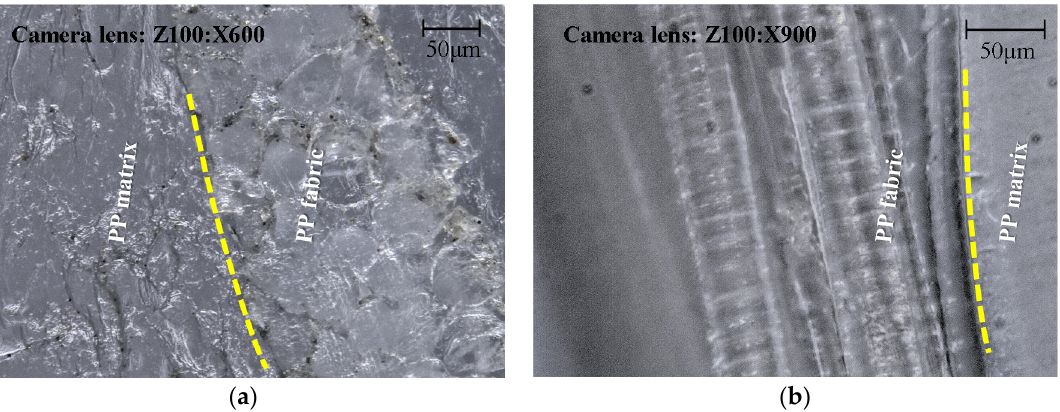
Figure 10. Digital microscopy pictures of the PP SPC sample: ( a ) cross-section of the sample from the side view and ( b ) fracture section of the sample after the tensile test from the top view.